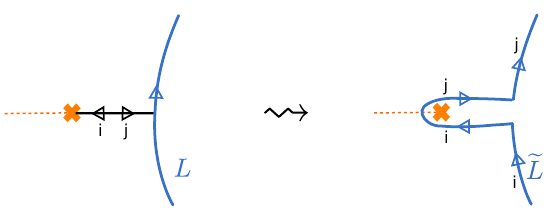
Figure 13 . Left: a web (shown in black) consisting of a single ij -segment with one end on a branch point and one end on the link L . Right: a lift e L containing the lift of the web.